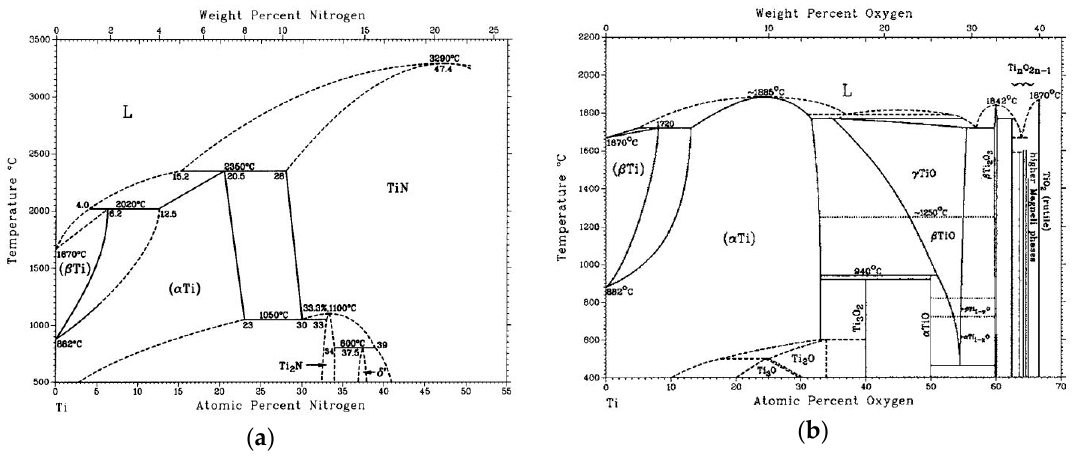
Figure 1. ( a ) N-Ti and ( b ) O-Ti phase diagrams. Figure 1a reprinted with permission from Ref. [47] and Figure 1b with permission reprinted from Ref. [48]. Copyright 1987 Springer Nature.